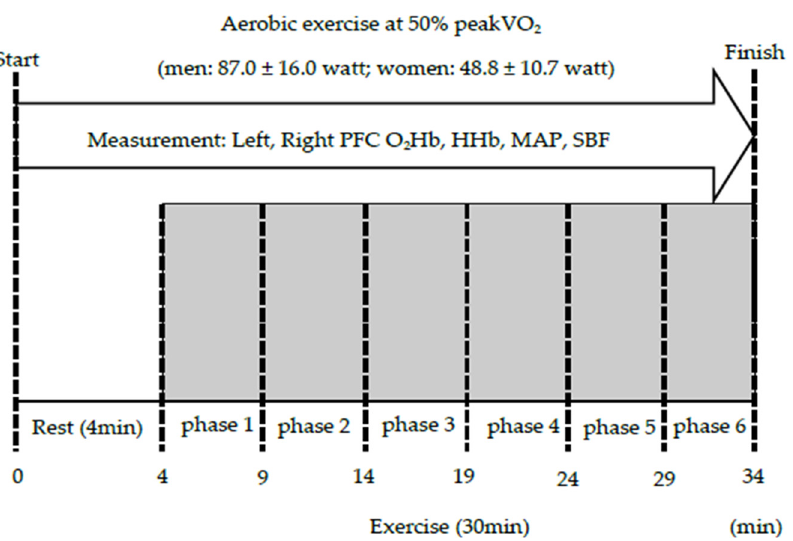
Figure 2. Experiment protocol. PFC: Prefrontal cortex, O 2 Hb: oxygenated hemoglobin, HHb: deoxygenated hemoglobin; MAP: Mean arterial pressure, SBF: Scalp blood flow.